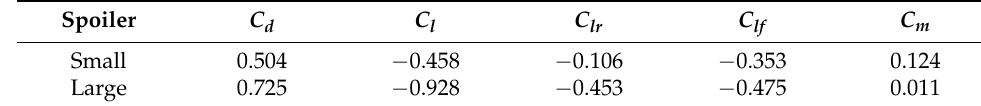
Table 5. Comparison of forces and moments obtained for different spoiler sizes, with the front wing located at X = 0 m and Y = 1 m from the front axle, with 0 degrees angle of attack.